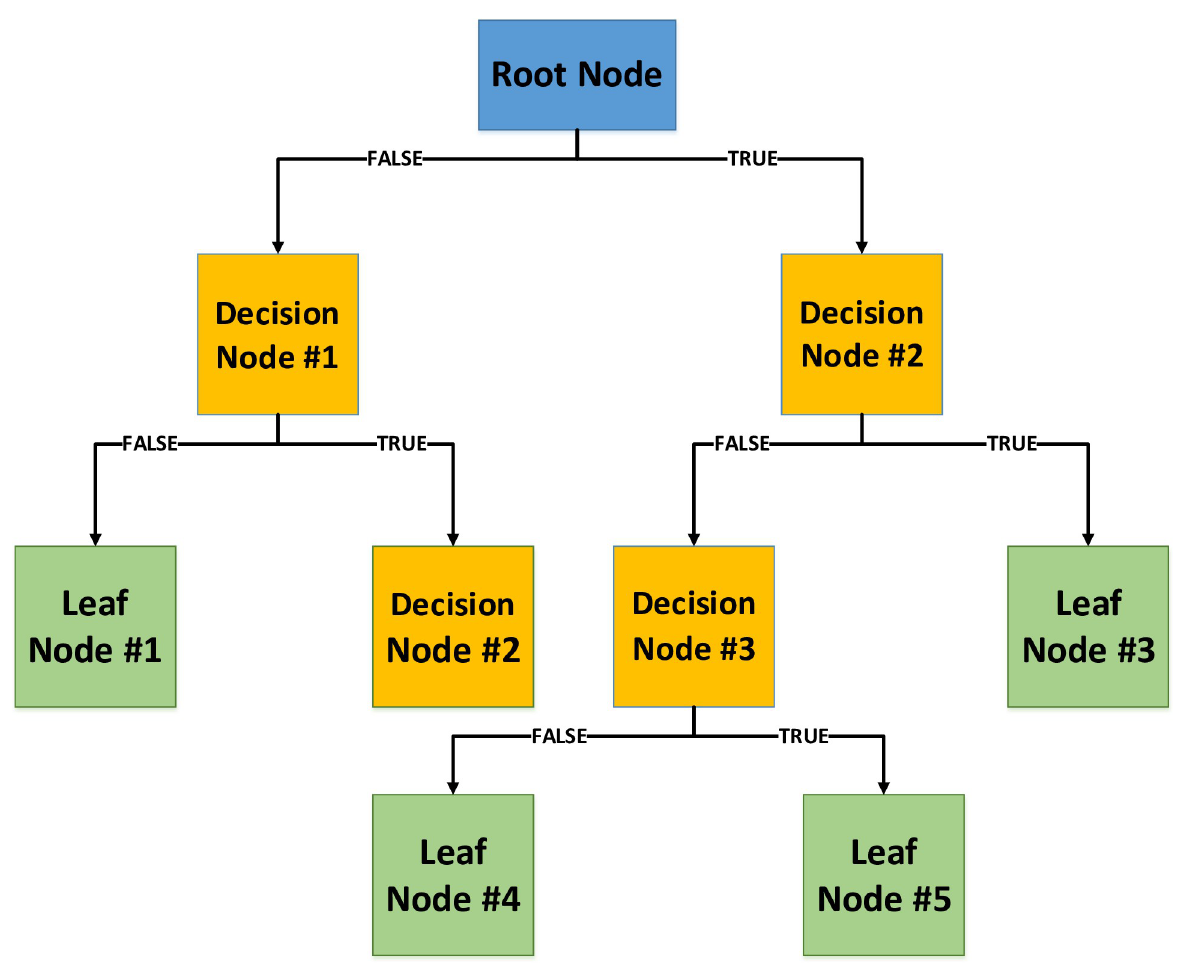
Fig 2. Structure of decision tree model.